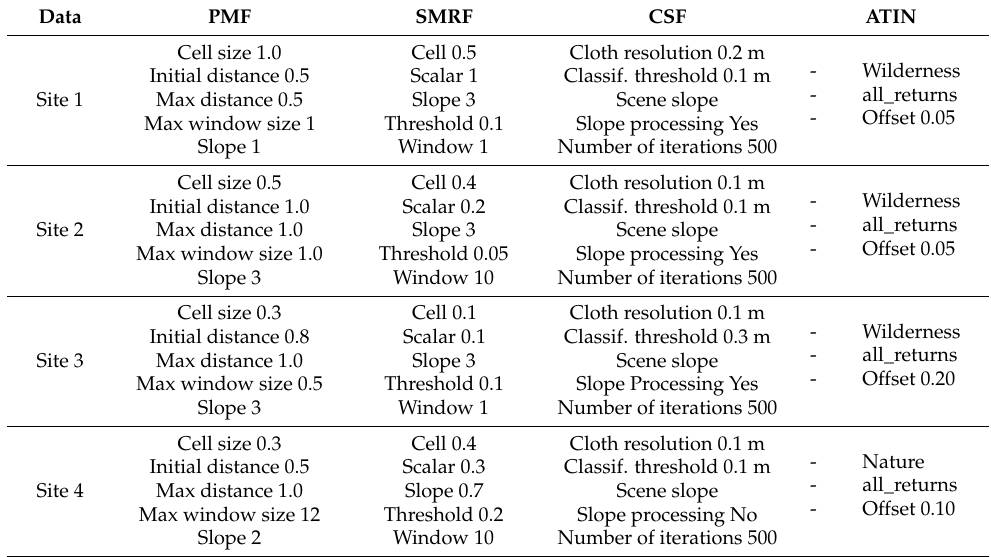
Table 2. Filtering parameters for individual filters and datasets (in meters or